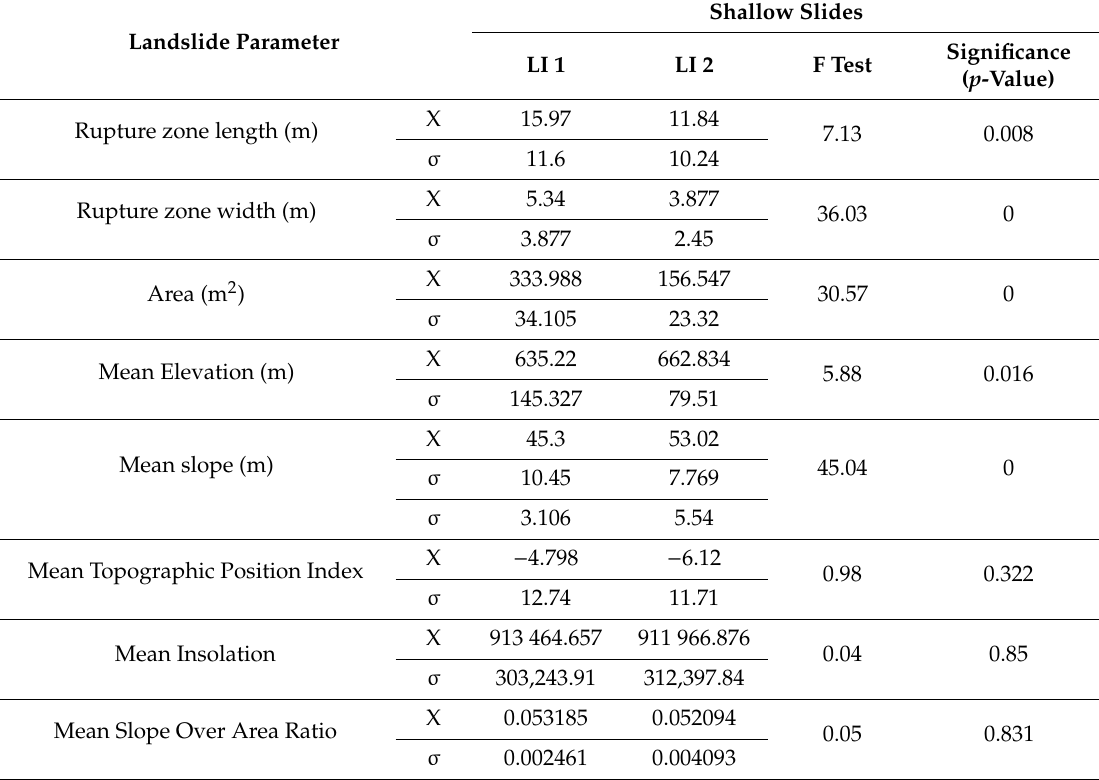
Table 1. One way analysis of variance ANOVA F test and significance level for landslide parameters of inventories of shallow slides for Landslide Inventory 1 (LI 1) and Landslide Inventory 2 (LI 2) (X = average; σ = standard